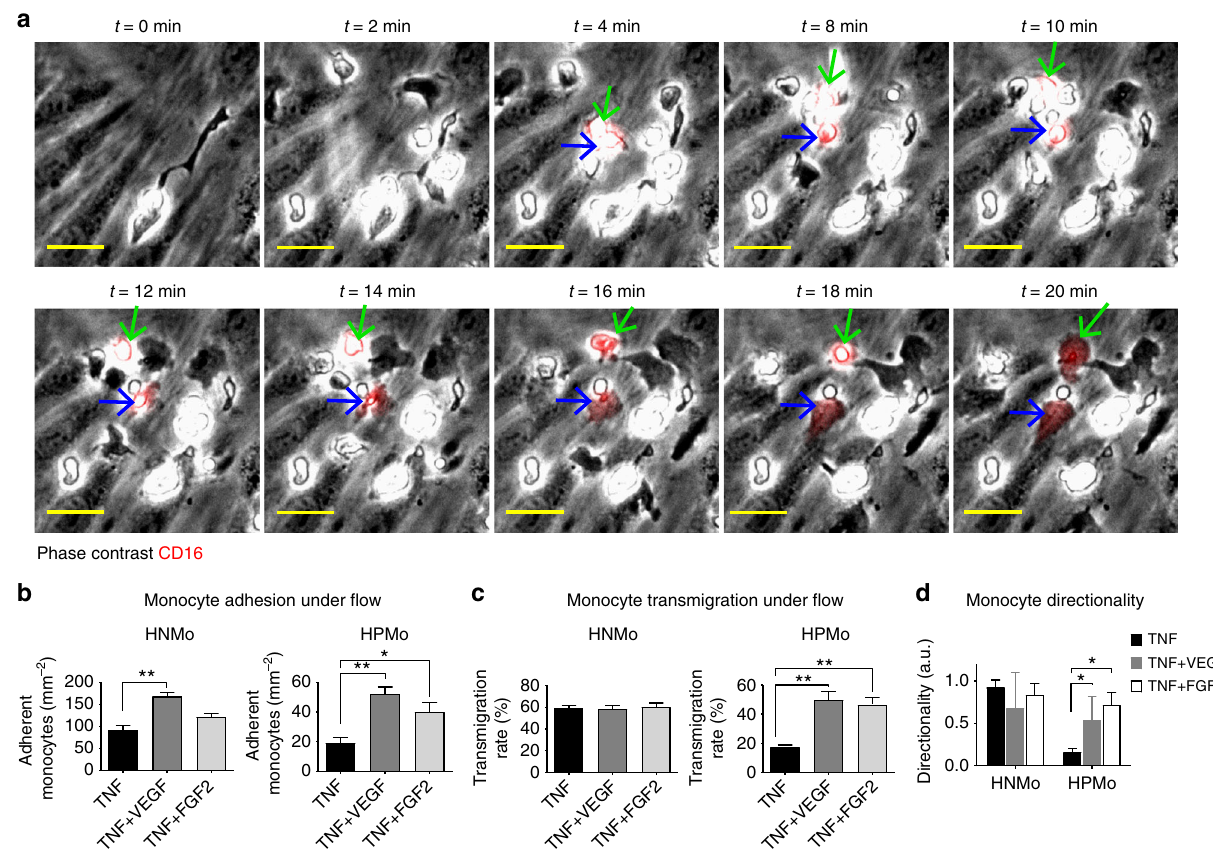
Fig. 5 Human proangiogenic monocytes transmigrate in angiogenic factor-driven in fl ammation. a Time-lapse imaging of proangiogenic monocyte transmigration assay under fl ow through endothelium activated with a combination of TNF and VEGF-A. Scale bar = 25 µ m. Green and blue arrows indicate two transmigrating proangiogenic monocytes. b Analysis of proangiogenic and non-angiogenic monocyte adhesion in ADIn (TNF + VEGF-A or TNF + FGF2) versus conventional (TNF alone) in fl ammation under fl ow. c Analysis of proangiogenic and non-angiogenic monocyte transmigration in ADIn versus conventional in fl ammation under fl ow. The data are presented as mean ± s.d., * p -value < 0.05 and ** p -value < 0.005 in ANOVA test. d Analysis of the directionality of monocyte subsets in ADIn versus conventional in fl ammation. The data in d are presented as mean ± s.d., * indicates p -value < 0.05 in Mann – Whitney test. The data were from 4 independent